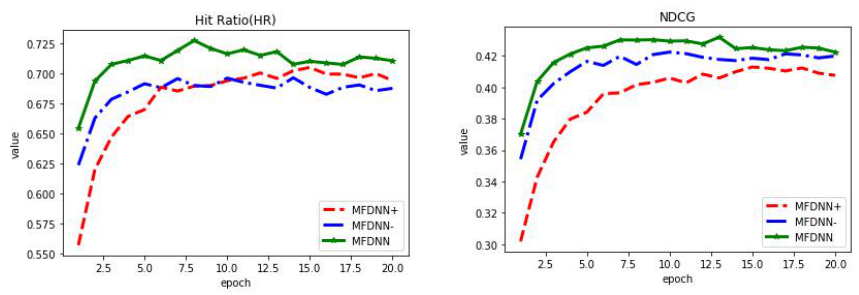
Figure 9. The HR and NDCG values achieved with MFDNN+, MFDNN-, and